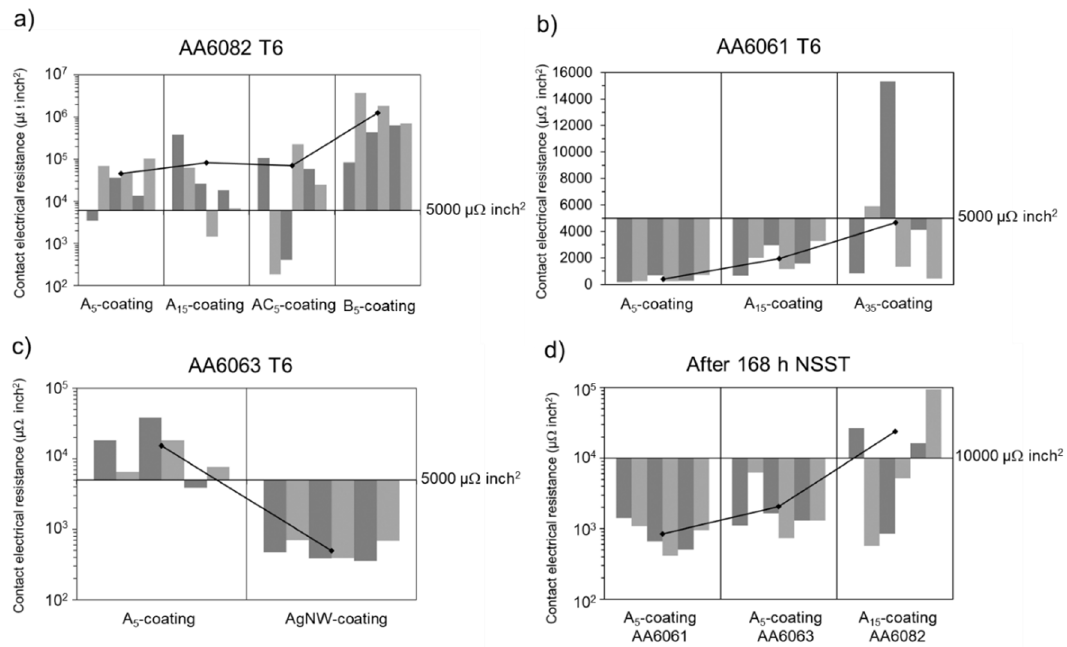
Figure 6. Contact electrical resistance measured on three AlSiMg alloys coated with the investigated sols ( a , b , c ) before and ( d ) after 168 h of exposure to NSST.